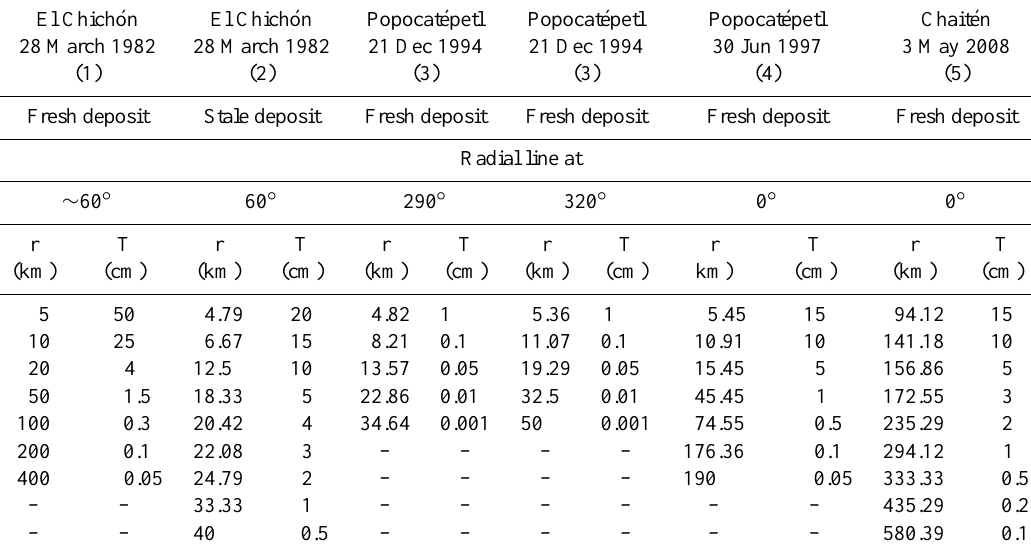
El Chich´on El Chich´on Popocat´epetl Popocat´epetl